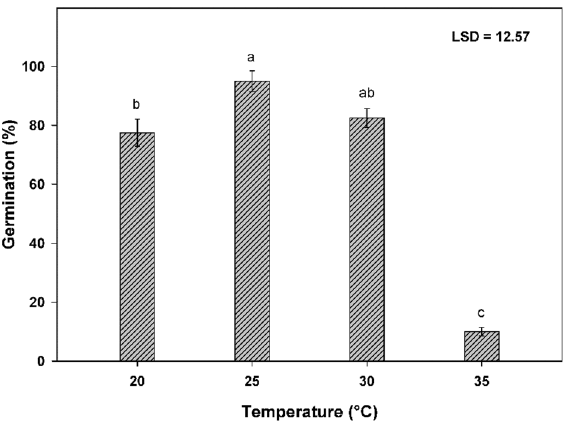
Figure 1. Influence of temperature on germination of perennial ryegrass. Nails on the vertical bars represent the standard error of the